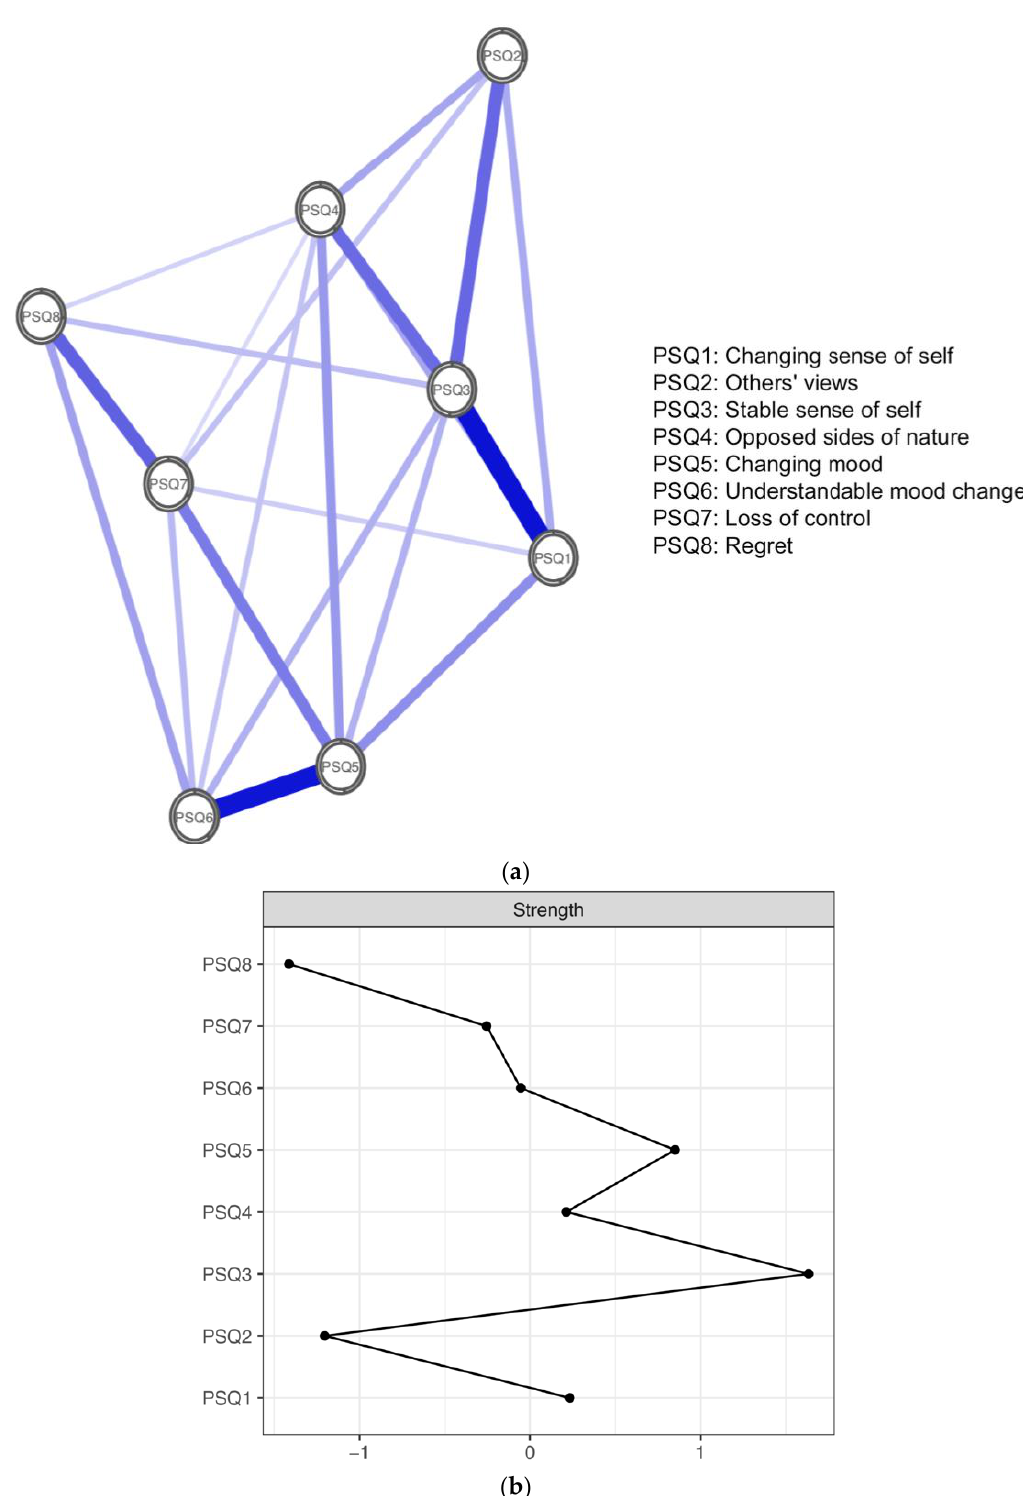
Figure 1. ( a ) Global network of identity disturbance across all datasets. Positive edges are represented by blue lines and shaded areas surrounding nodes represent node predictability. ( b ) Plot of node strength centrality.